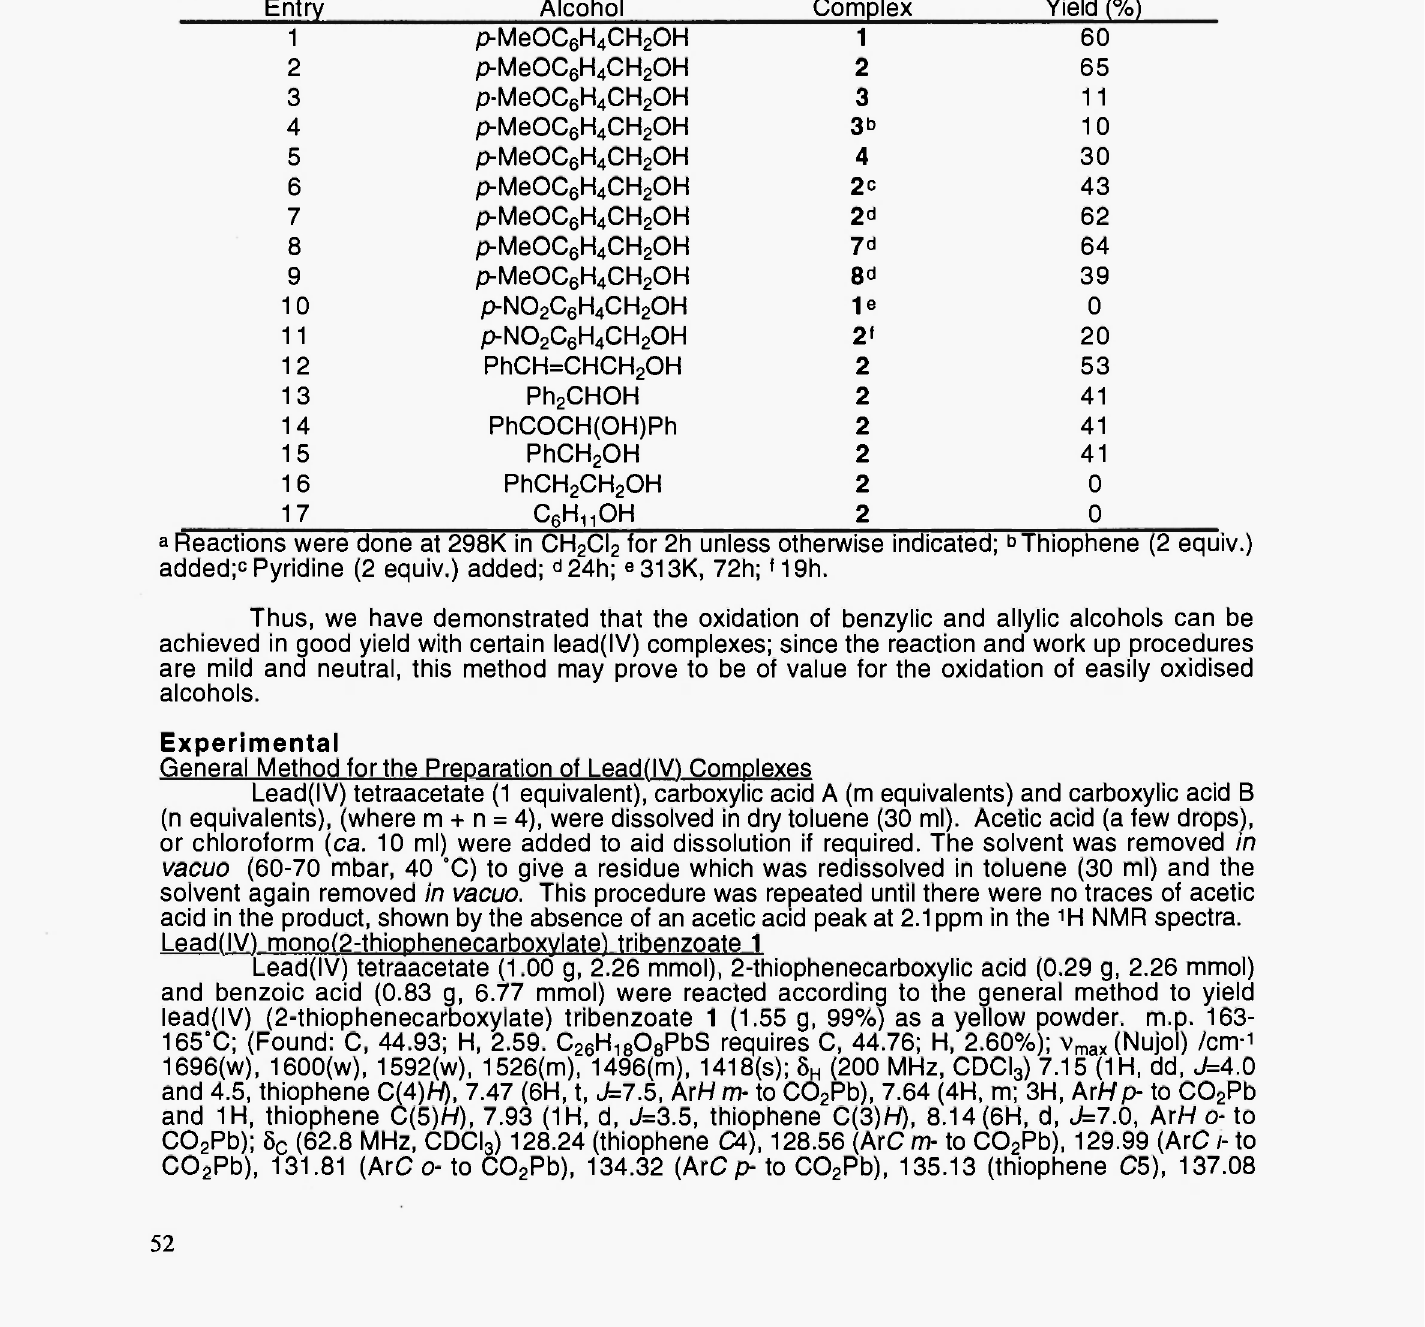
Table: Reaction of Alcohols with Lead(IV) tetracarboxylates to give Corresponding Aldehydes 3 Entry Alcohol Complex Yield (%) 1 p-MeOC 6 H 4 CH 2 OH 1 60 2 p-MeOC 6 H 4 CH 2